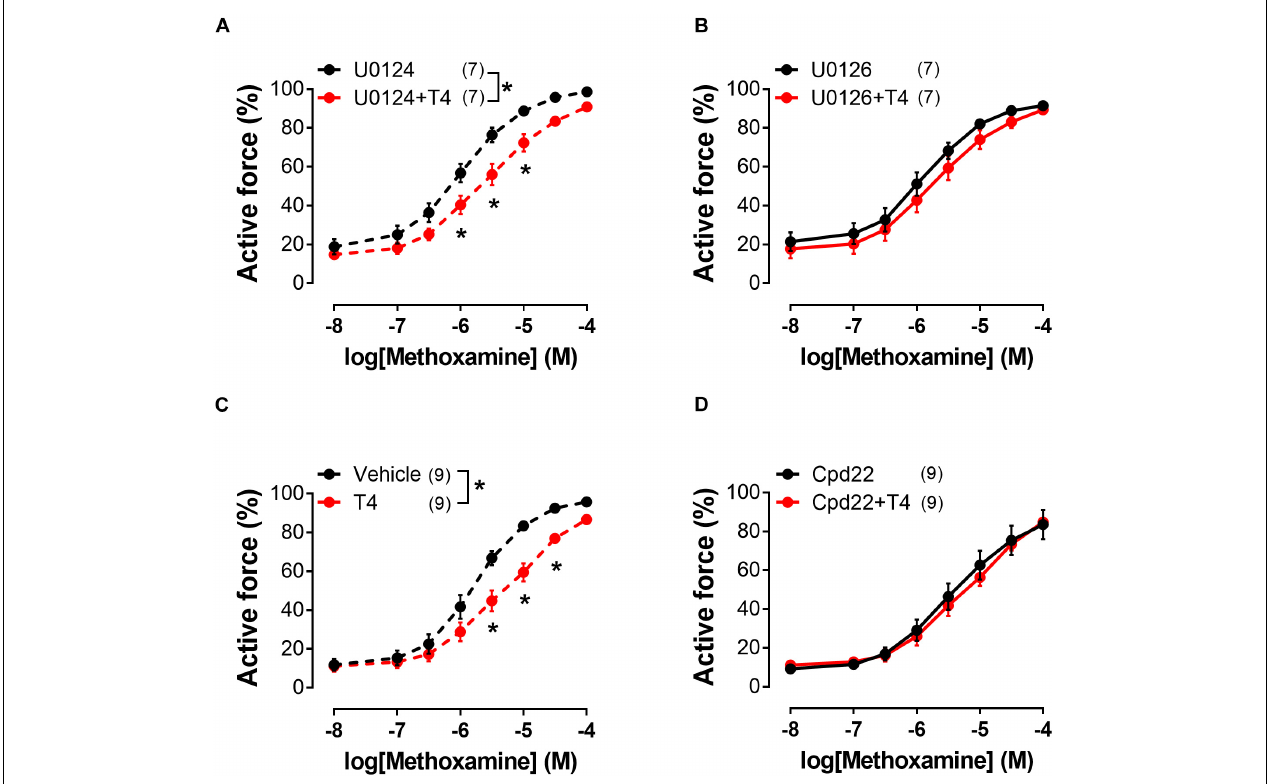
FIGURE 6 | Inhibitor of ERK1/2 activation (U0126) and inhibitor of ILK (Cpd22) abolish the effects of T4 on contractile responses of endothelium-denuded sural arteries to methoxamine. Concentration-response relationships to methoxamine obtained after preincubation with T4 or vehicle in the presence of: U0124 (A) (inactive analogue of U0126, 10 µ M), U0126 (B) (10 µ M), DMSO (C) (vehicle for Cpd22), and Cpd22 (D) (10 µ M). Number in parentheses represents the number of animals. * p < 0.05 compared to respective control group (Repeated Measures ANOVA with Tukey’s post hoc test).